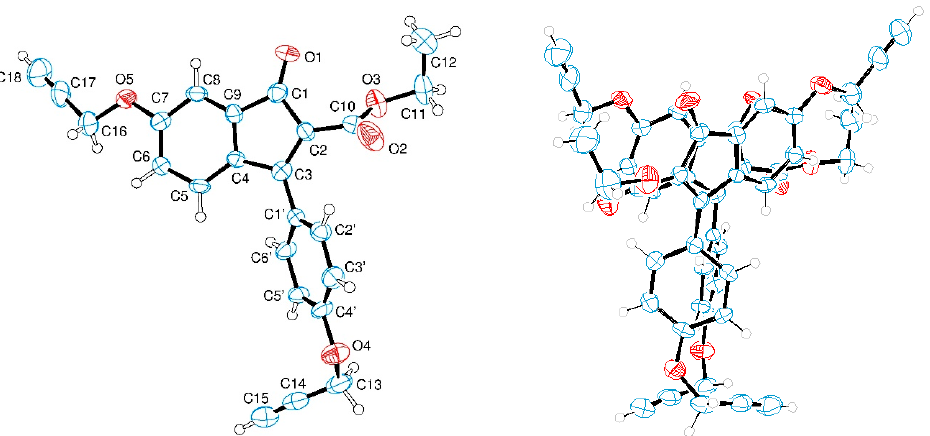
Figure 4. Structure of indenone derivative 9 found by crystallography. Single molecule ( left ) and two packed molecules ( right ). Ellipsoids enclose 50% probability.